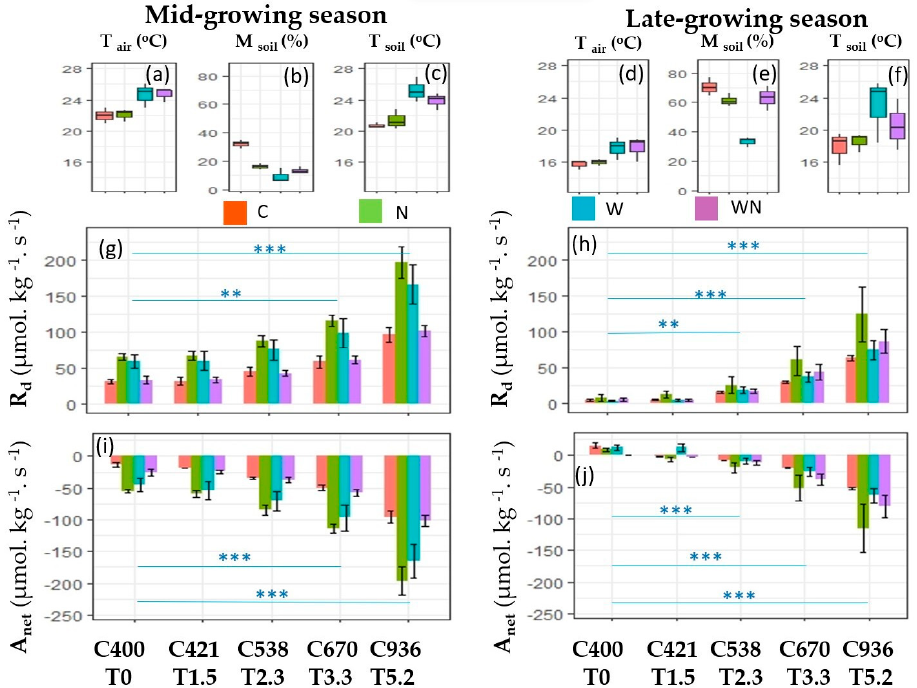
Figure 3. The dark respiration (R d ) ((( g ) for the mid-growing season, (( h ) for the late-growing season) and net photosynthesis (A net ) ((( i ) for the mid-growing season, (( j ) for the late-growing season) of S. fuscum in both CO 2 and temperature increments (CTI) conditions stimulating future climate scenarios for the year 2100 in the Control (C-red bars), N addition (N-green bars), warming (W-blue bars) and both N addition and warming (NW-purple bars) plots. Error bars represent the standard error of the mean (n = 3). Stars indicate the p -value of the Tukey test for significant differences of R d and A net between levels of CTI ( p < 0.05, **: p < 0.01, ***: p < 0.001). Box plots show environmental variables, including air temperature (T air ) ((( a ) for the mid-growing season), (( d ) for the late-growing season), soil moisture (M soil ) ((( b ) for the mid-growing season), (( e ) for the late-growing season), and